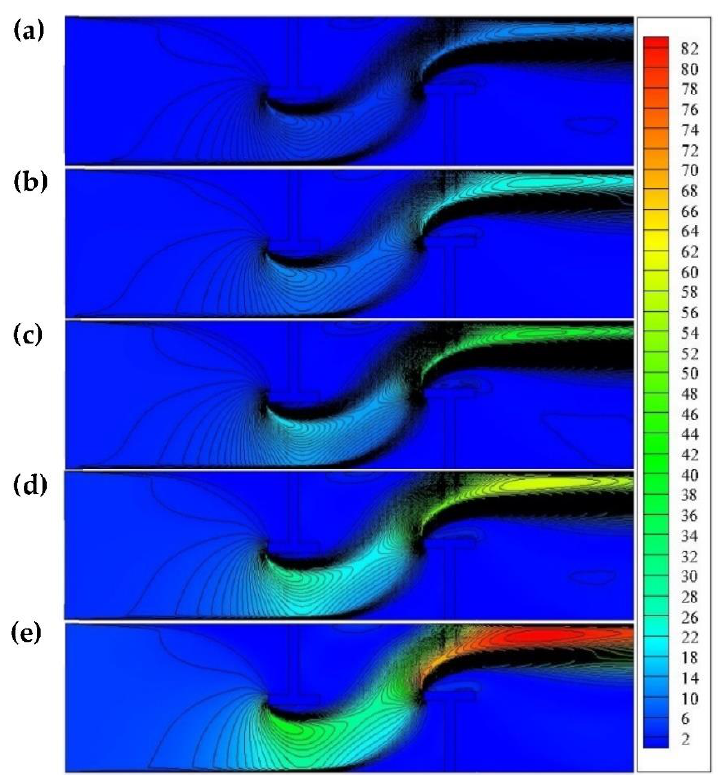
Figure 7. Distribution of the dynamic pressure for: Re = ( a ) 12,000; ( b ) 17,000; ( c ) 22,000; ( d ) 27,000; ( e ) 32,000.